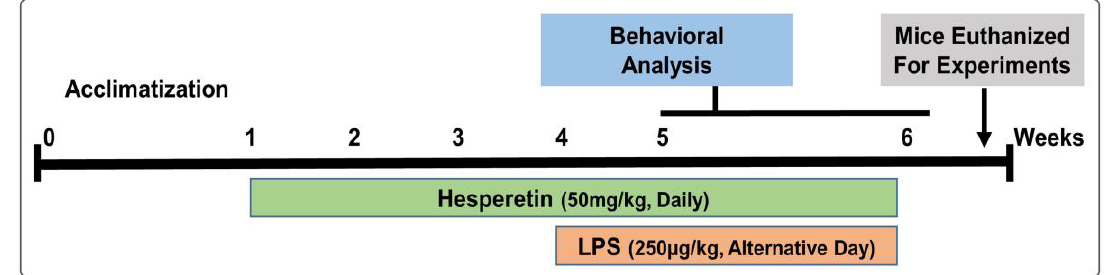
Figure 1. Schematic diagram of the experimental design showing the duration of the lipopolysaccharide (LPS) and/or hesperetin administration in adult mice and behavioral analysis.